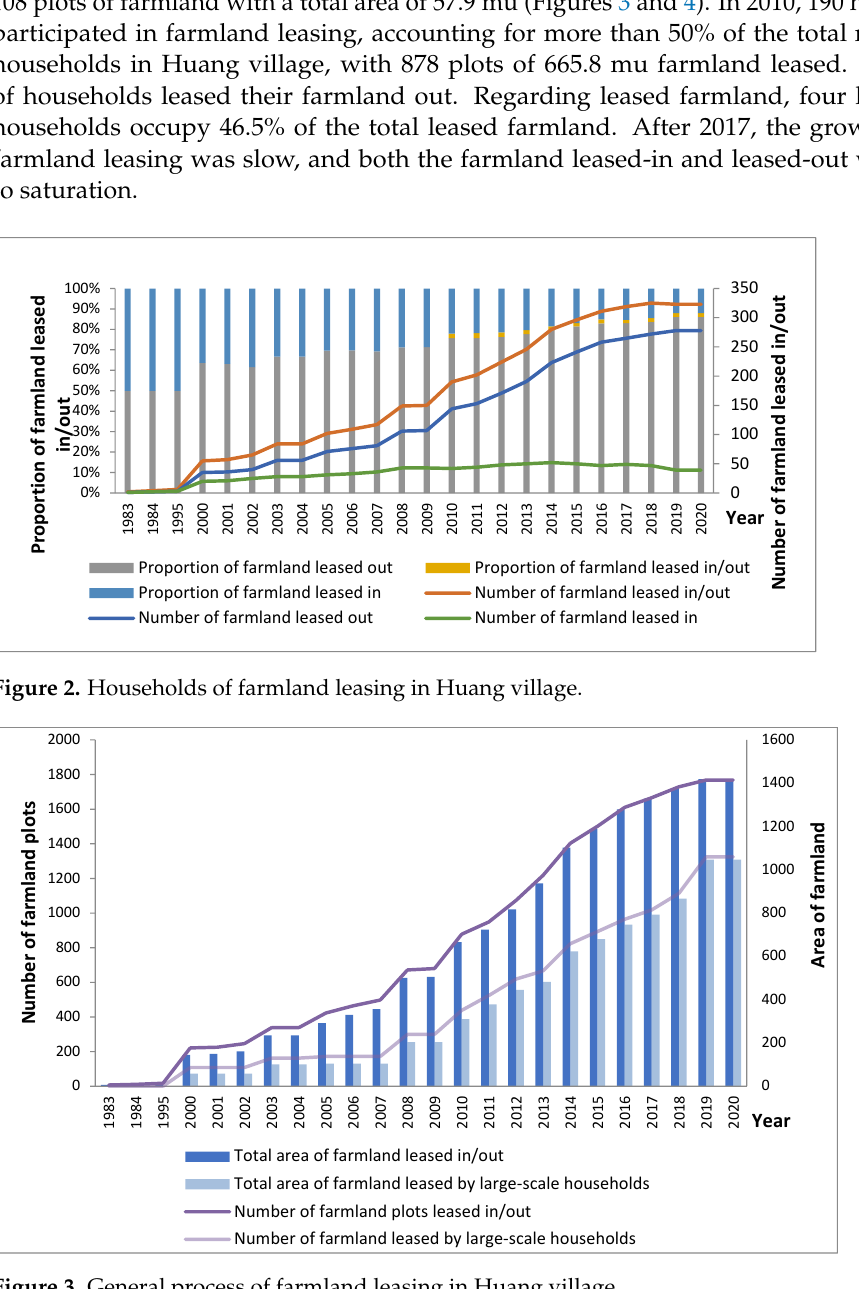
Figure 4. Farmland leasing of large-scale household in Huang village.